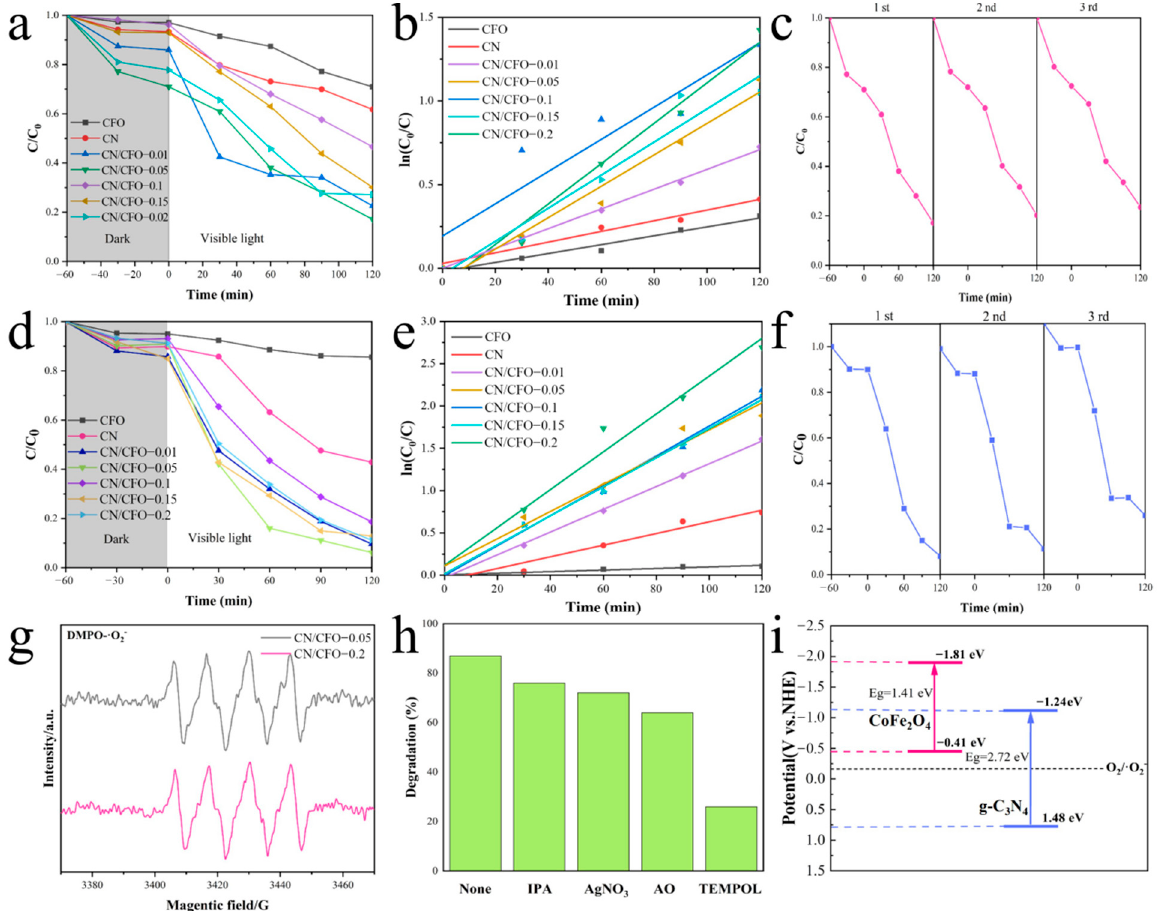
Figure 4. Photocatalytic degradation efficiency of CN/CFO for TC, first-order reaction kinetics, and degradation efficiency after three cycles ( a – c ); photocatalytic degradation efficiency of CN/CFO for MB, first-order reaction kinetics, and degradation efficiency after three cycles ( d – f ); EPR spectra of CN/CFO-0.05 and CN/CFO-0.01 in the presence of DMPO ( g ); radical capture experiment results ( h ); energy band structure of the catalysts ( i ).